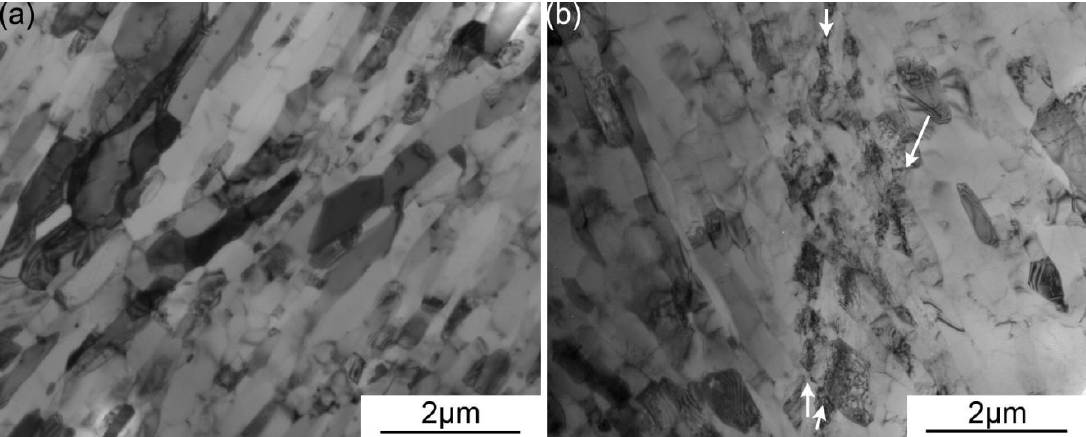
Figure 5. Bright field TEM micrographs of 8p ARBed CP aluminum samples ( a ) in the as-ARBed form; and ( b ) after cyclic loading under load controlled with peak stress σ = 90% σ and R = 0.05 after cyclic fracture at 44404 cycles. The observed shear bands peak y in the form of braids of dislocations are arrowed in ( b